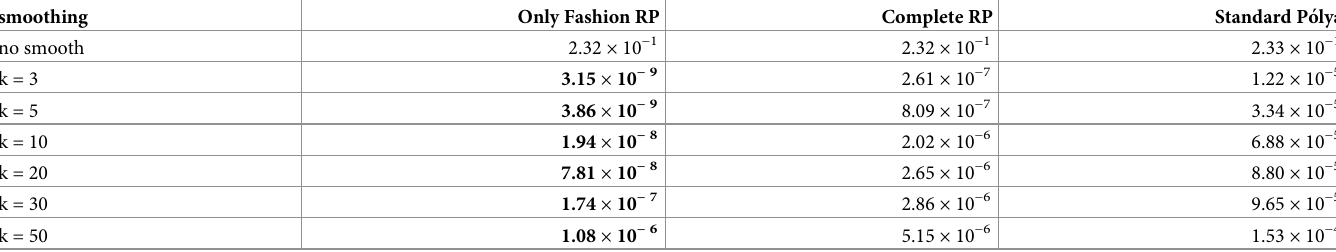
Table 9. “10 days of traffic” ( T = 0.35, entire, D = 30 00 , S = 100 slots of equal size): MSE for different levels of smoothing. smoothing Only Fashion RP Complete RP Standard Po´lya no